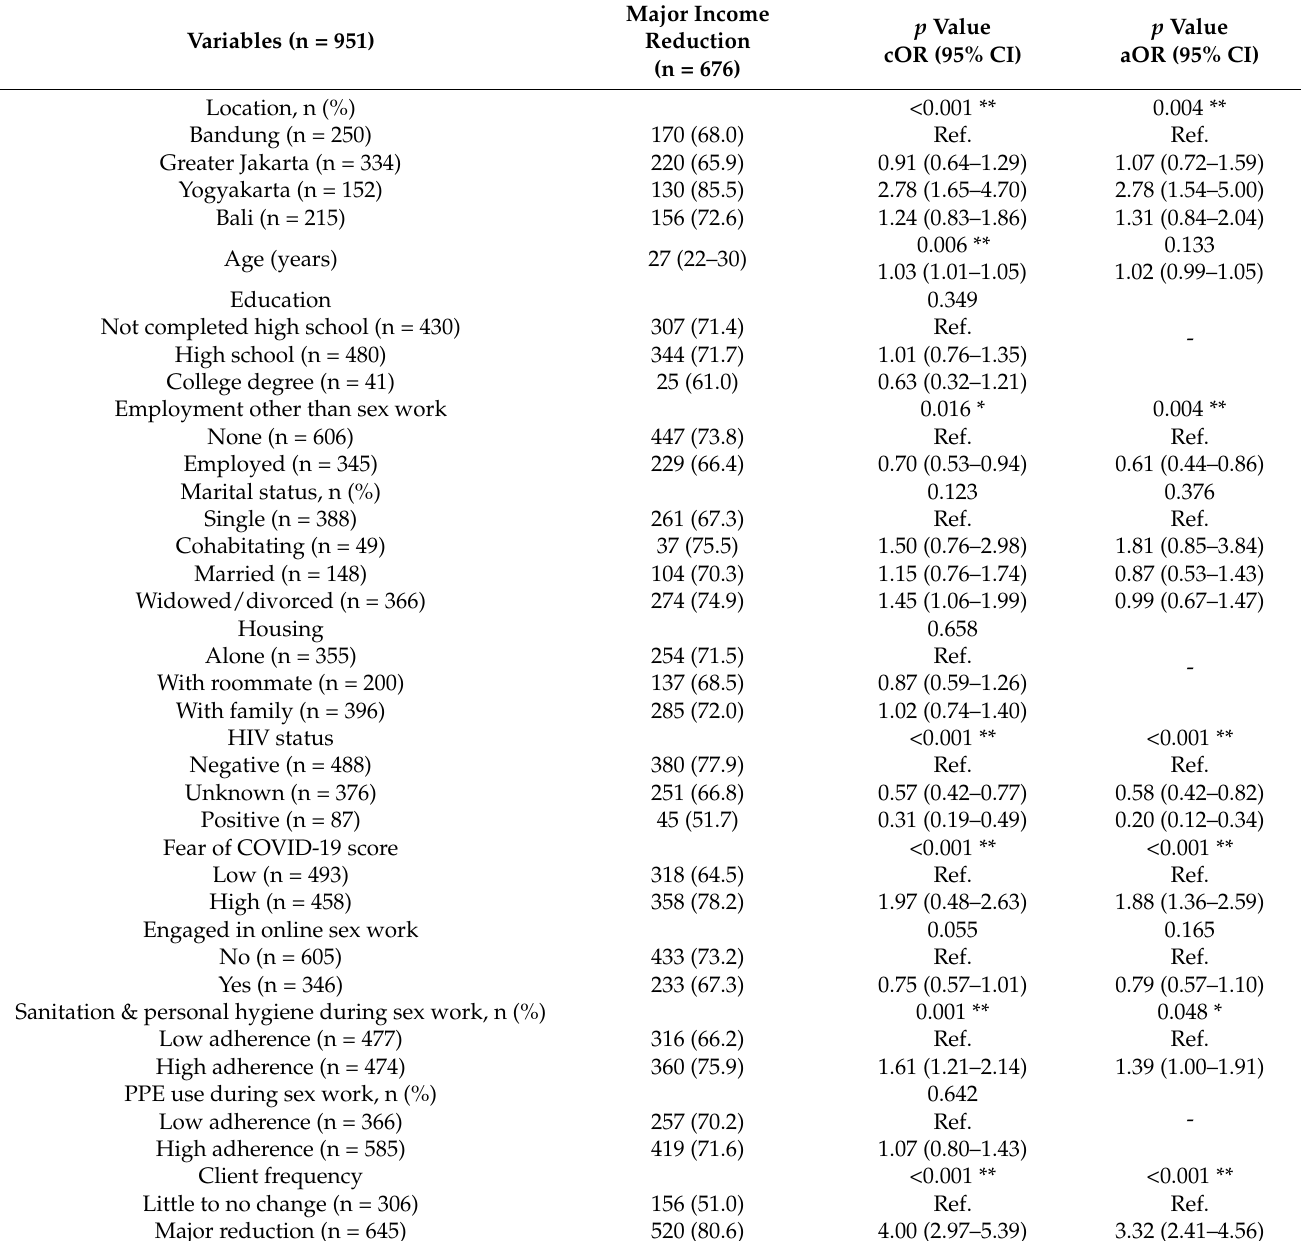
Table 4. Risk factors for major reduction of income during the COVID-19